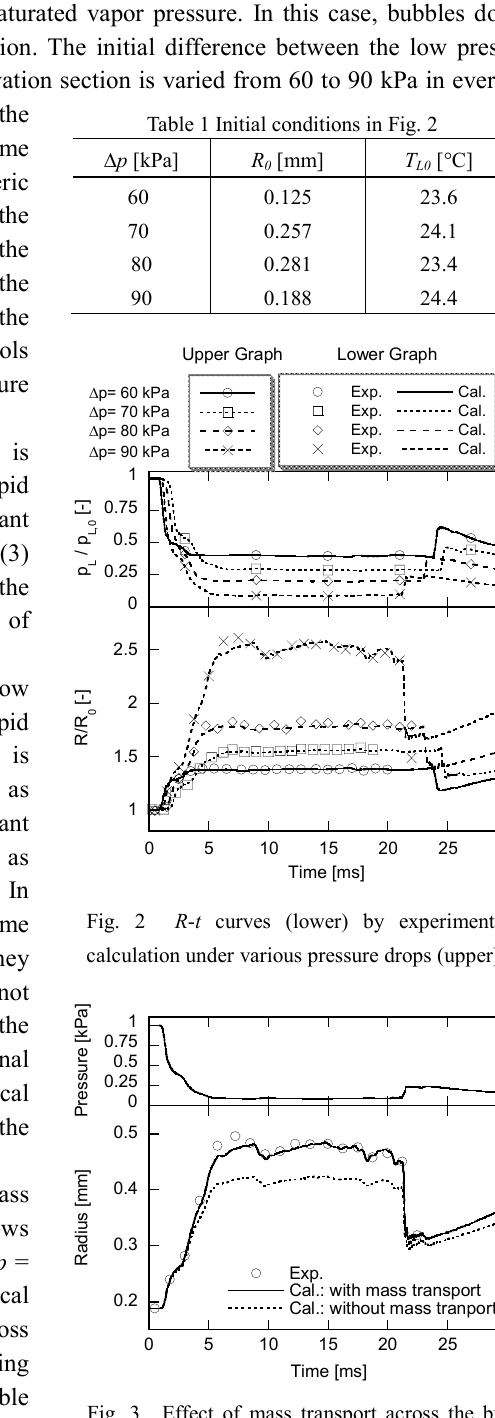
Fig. 3 Effect of mass transport across the bubble wall for Δ p = 90 kPa. The minimum ambient pressure was above the saturated vapor